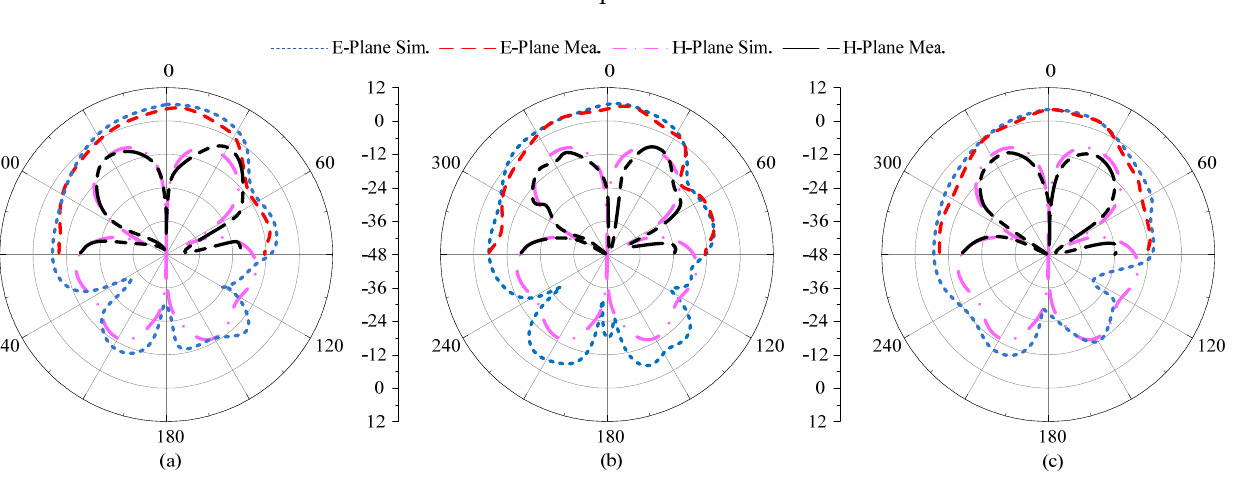
Figure 11. Surface Current distribution of proposed MIMO antenna at ( a ) 27 GHz ( b ) 28 GHz. 4.4. Envelop Correlation Co-Efficient Envelop correlation coefficient (ECC) is one of the most important parameters to study MIMO antennas behavior. For the proposed MIMO antenna, the ECCs for adjacent antennas element-1 and element-3 were simulated and measured as shown in Figure 12. The ECC can be evaluated in terms of scattering parameters or in terms of radiation pat- terns by using the formulas given in [35]. It is observed from Figure 12 that the ECC of the proposed MIMO antenna has a value < 0.0005, which is in an acceptable range and good enough for effective MIMO communication.